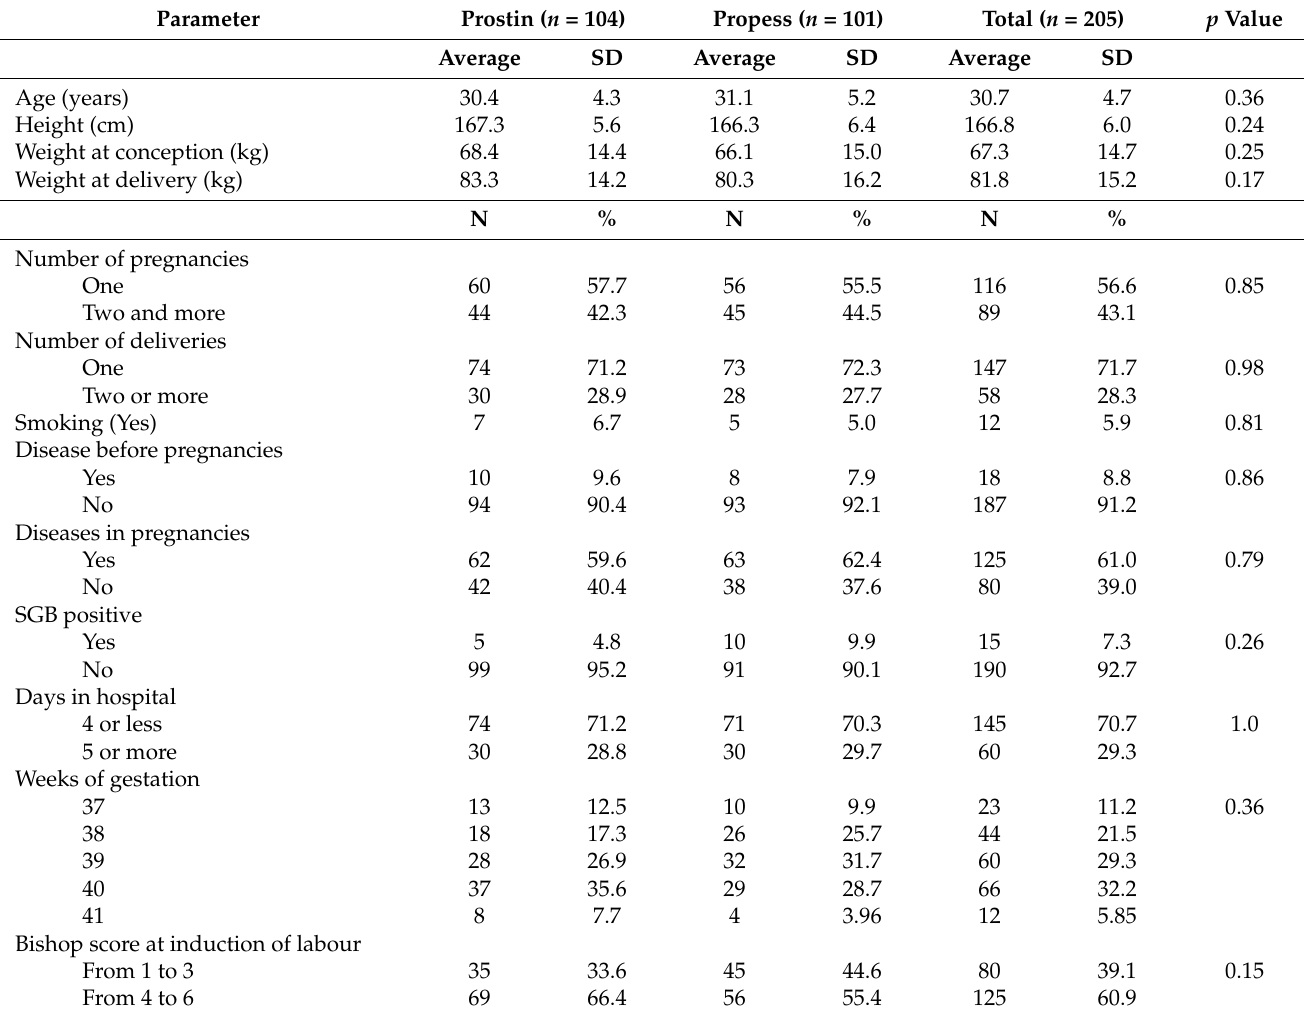
Table 1. Demographic characteristics of the study population according to the study groups. SGB—